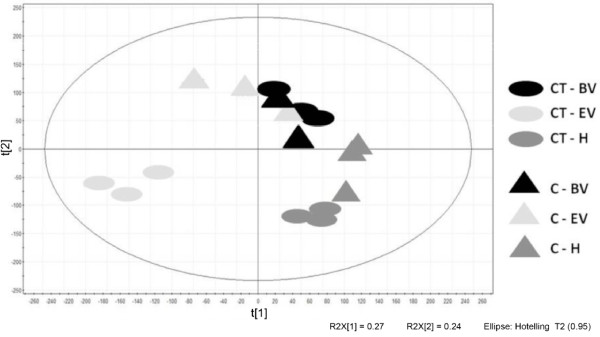
Principal component analysis (PCA) shows that the most severe changes are at the end of veraison. Biological replicates relative to time point beginning of veraison (BV), end of veraison (EV) and harvest (H) are represented as circles for CT and as triangles for C.